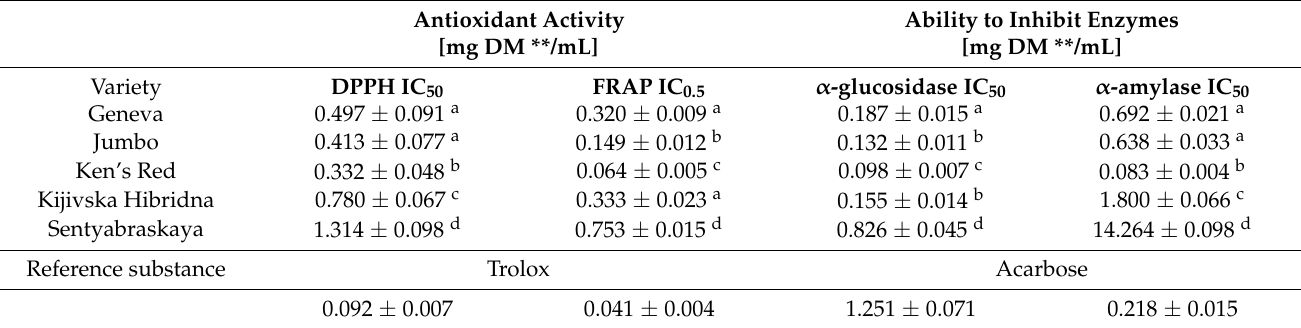
Table 2. IC 50 and IC 0.5 of antioxidant activity and enzyme inhibition of the studied Actinidia varieties. Antioxidant Activity [mg DM **/mL]